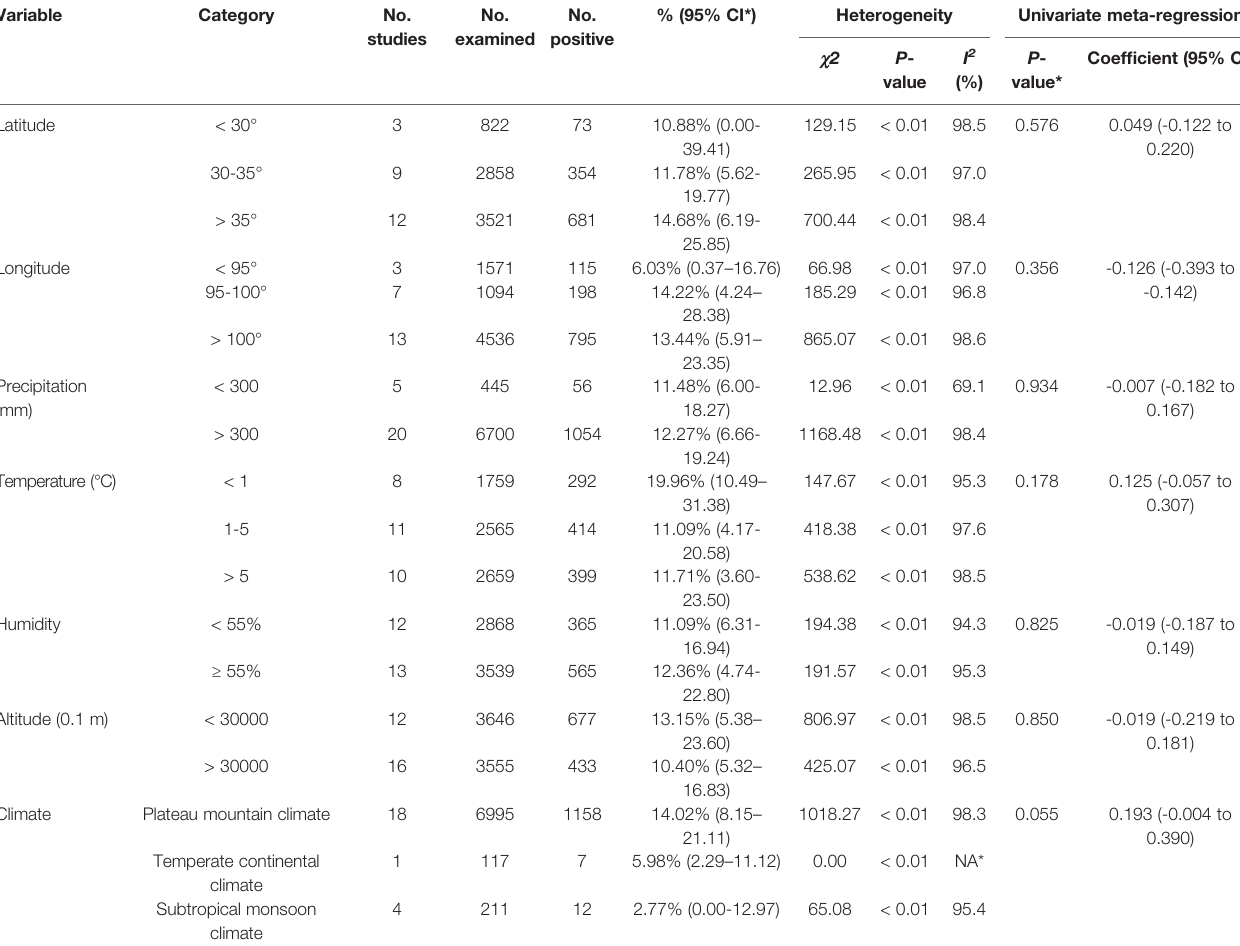
TABLE 5 | Sub-group analysis of the prevalence of Cryptosporidium according to geographic location and climate variables. Variable